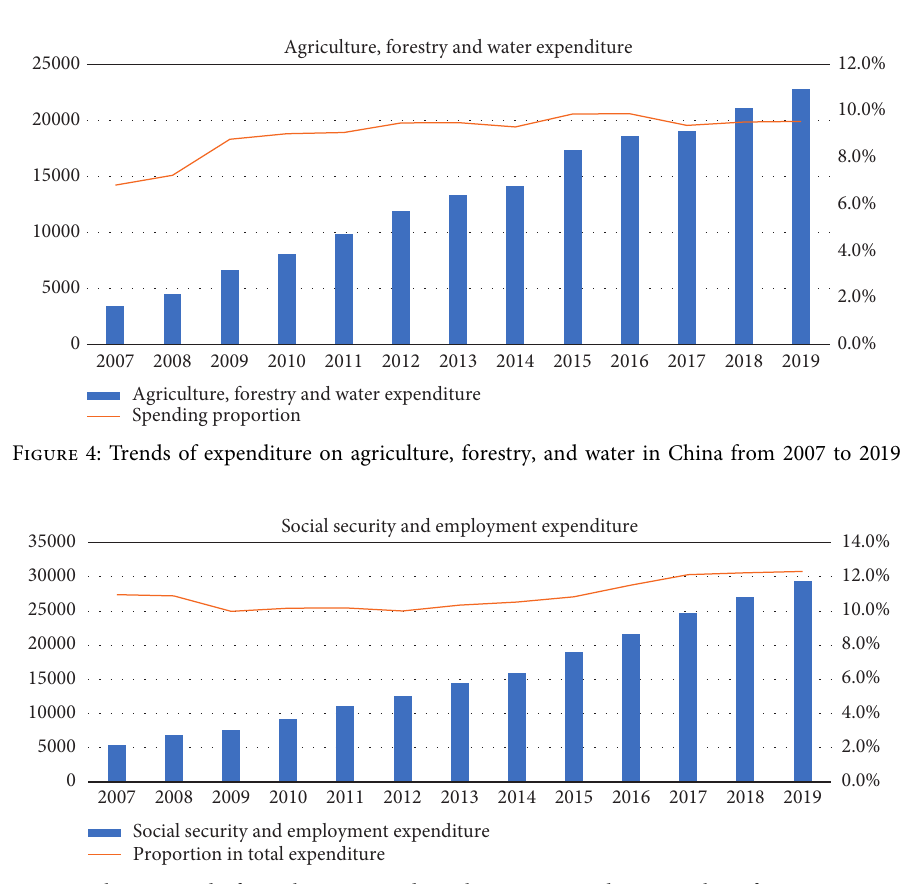
Figure 5: Change trend of social security and employment expenditure in China from 2007 to